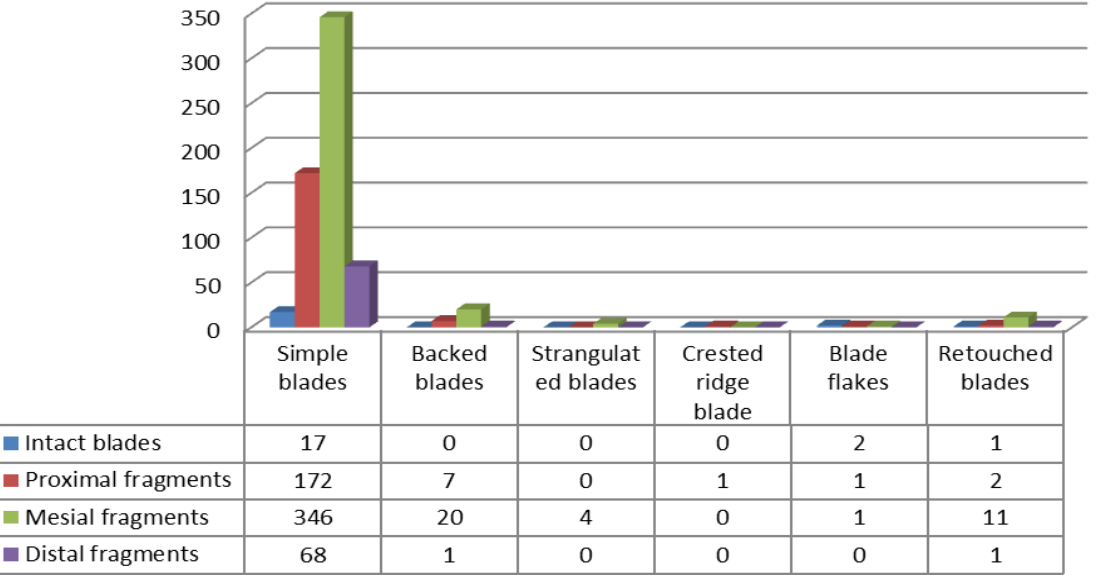
Figure 5: condition of Rohri chert blades